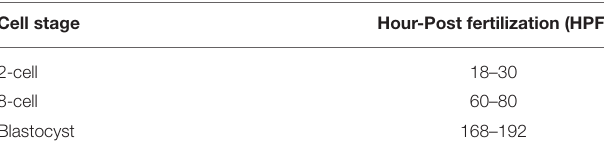
TABLE 1 | Spent media collection schedule at various stages [adapted from Van Soom et al. (Van 18), Perkel and Madan